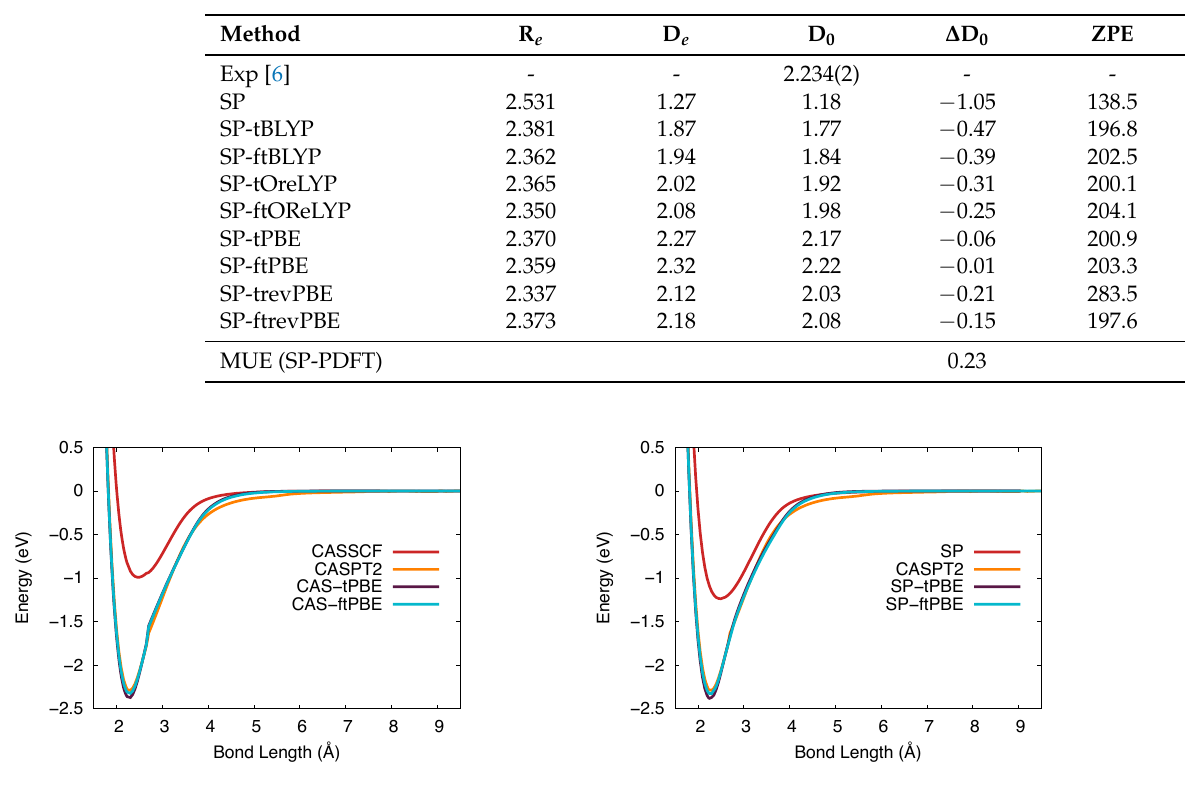
Table 7. Dissociation energies (eV), equilibrium bond lengths (Å), and zero point energies (in cm − 1 ) for VSi in the 2 ∆ molecular state, computed with a SP wave function.